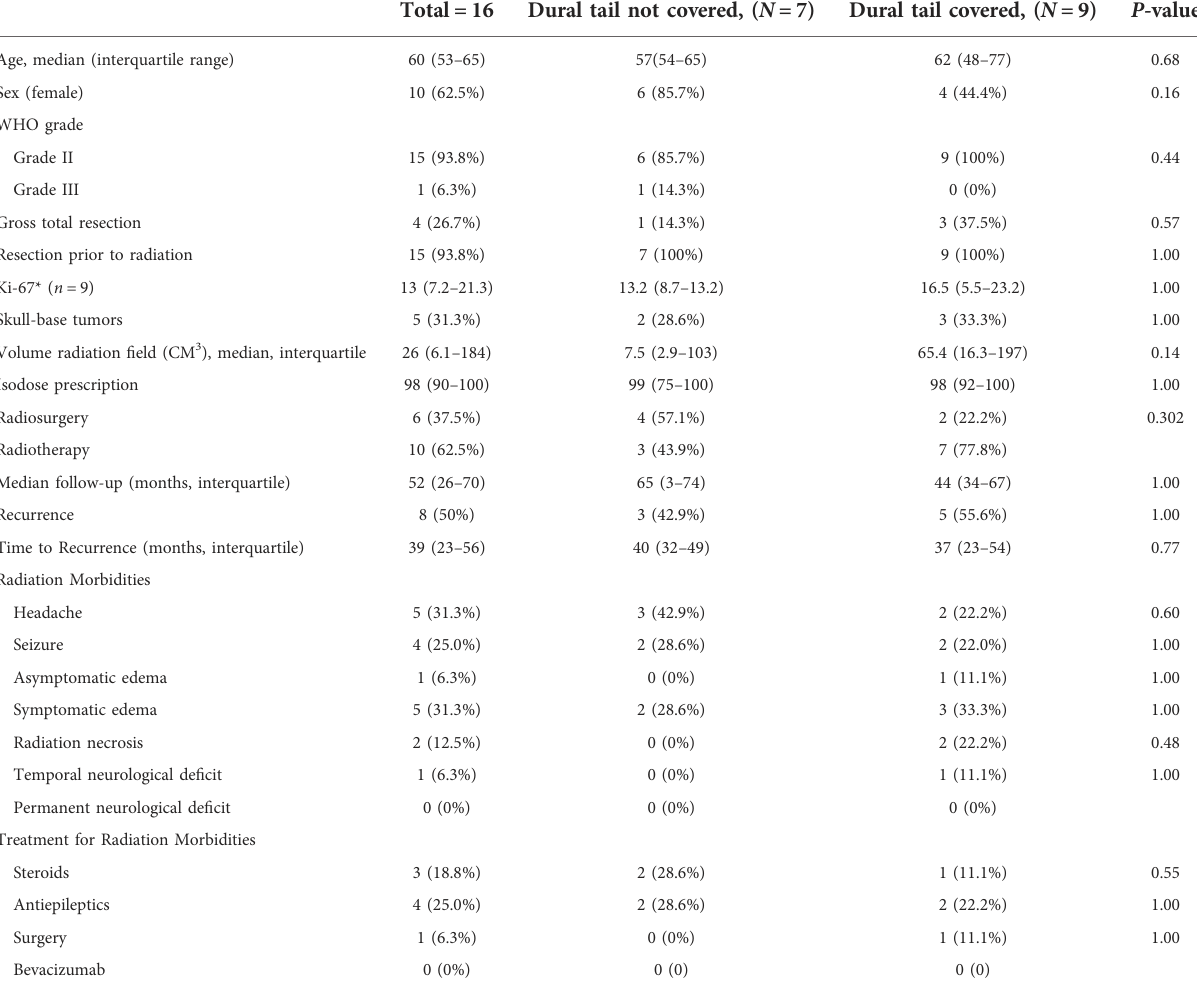
TABLE 5 Grade 2 and 3 cohort demographics and